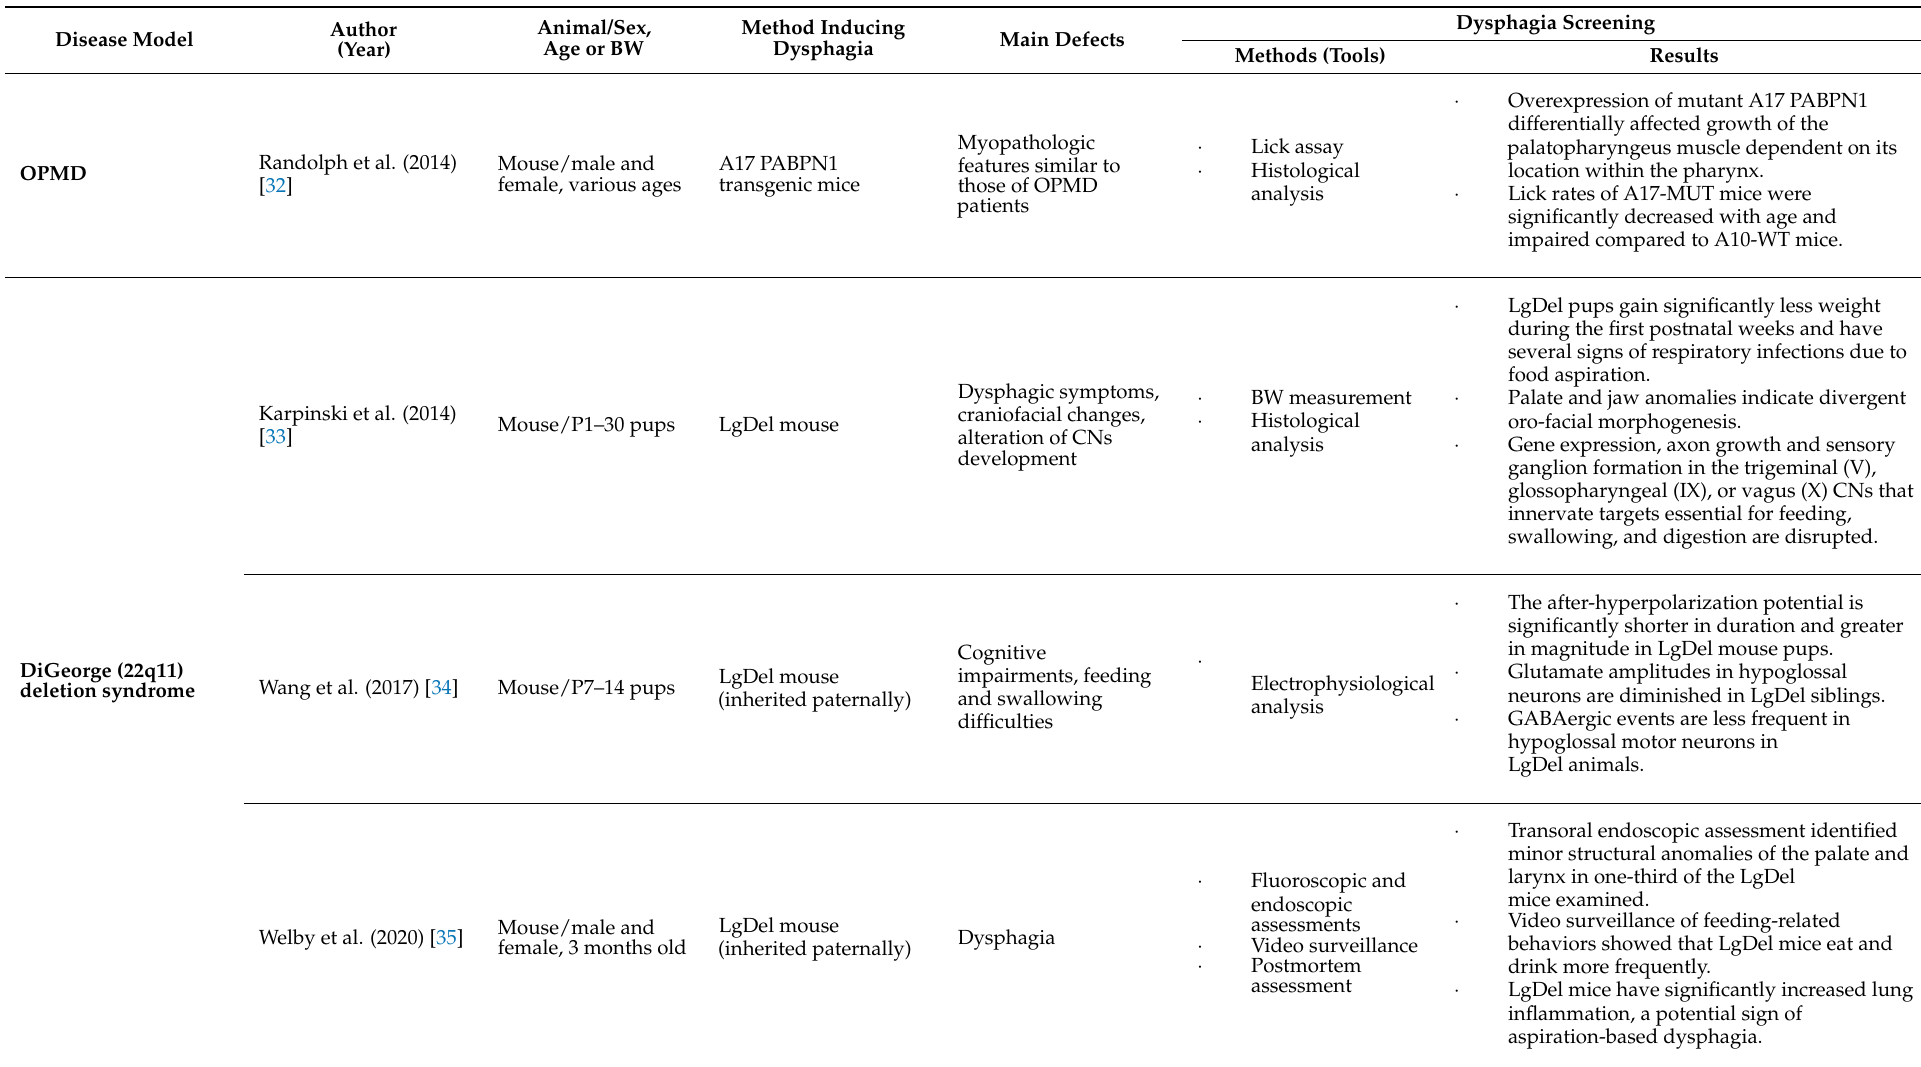
Table 4. Characterization of oropharyngeal dysphagia in rodent models of other